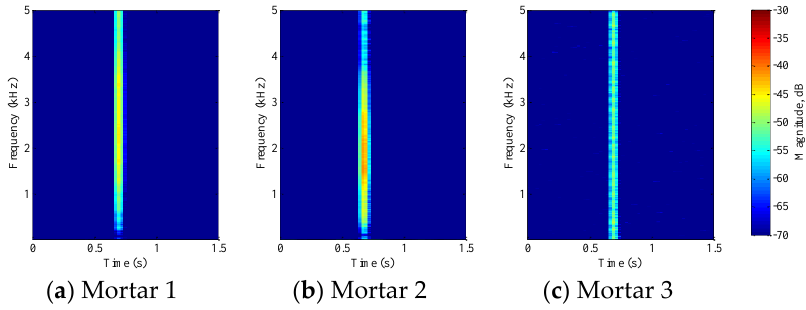
Figure 9 . STFT of PVDF sensor signal for PVA-ECC 3.